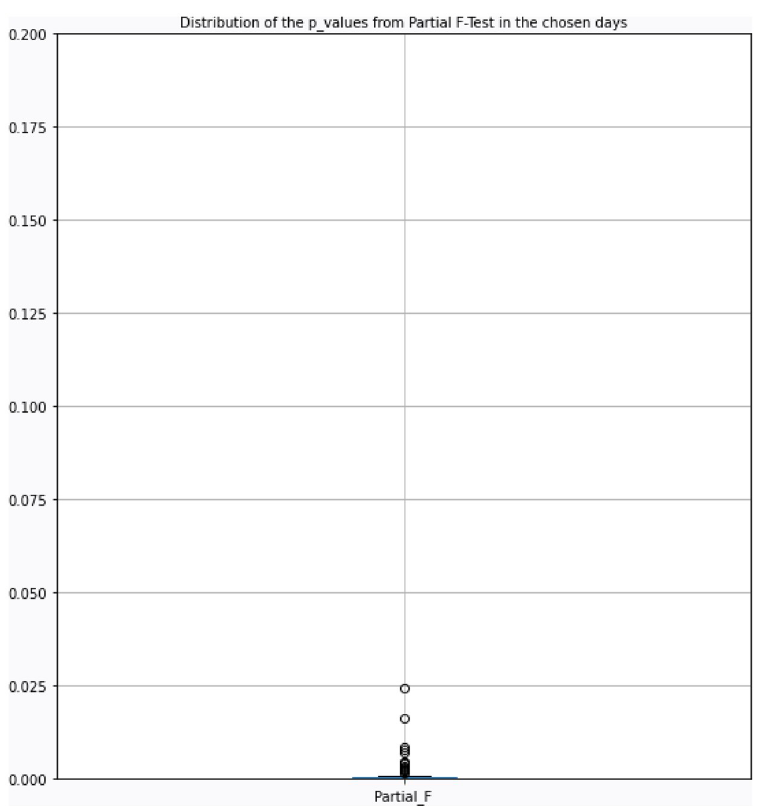
Fig 17. Boxplot of the p-values from the partial F-Test on the days where topic score models are chosen over the benchmark for the private data.